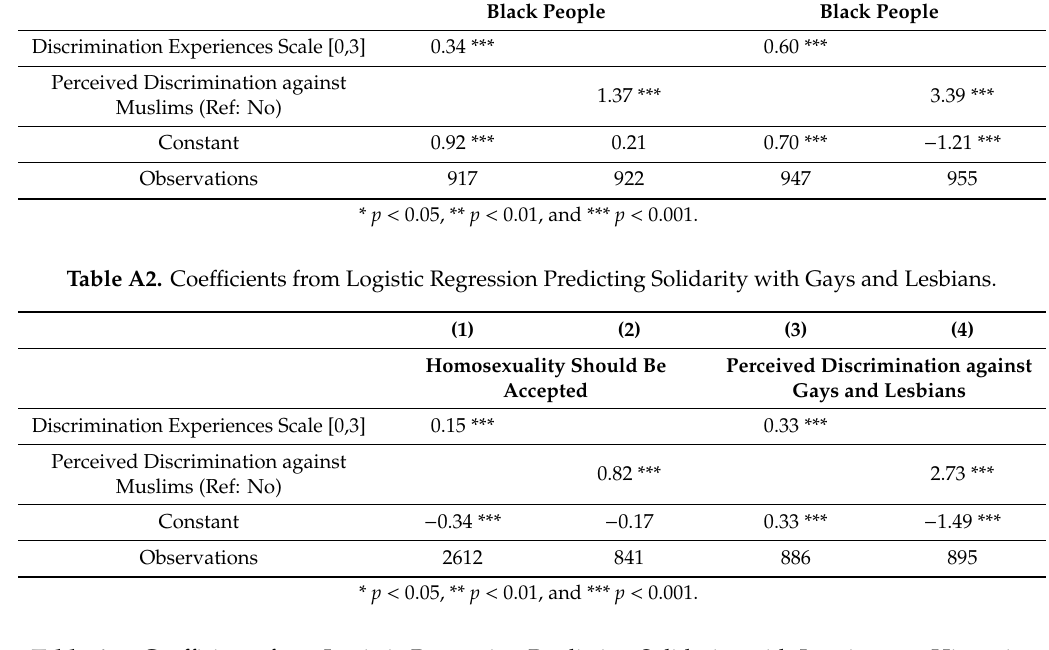
Table A3. Coe ffi cients from Logistic Regression Predicting Solidarity with Immigrants, Hispanics and Jews.